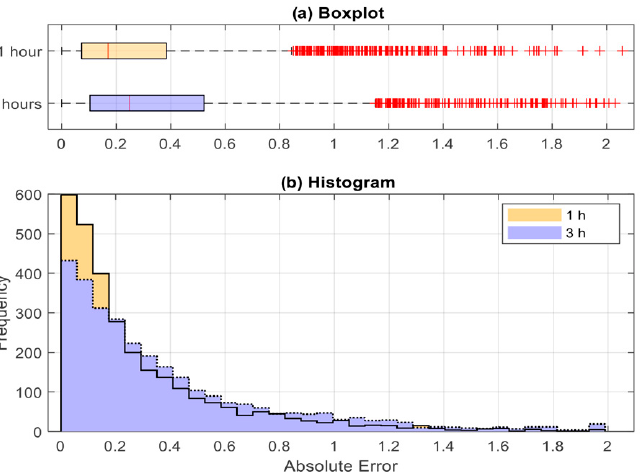
Figure 11. Absolute error using VOA to forecast 1 h ahead and 3 h ahead: ( a ) histogram and ( b ) boxplot.